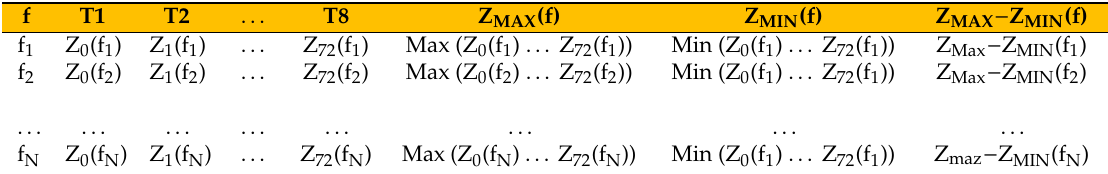
Table 3. Impedance measurement in a range of frequencies (f 1 –f N ) at di ff erent times (T1–T8).